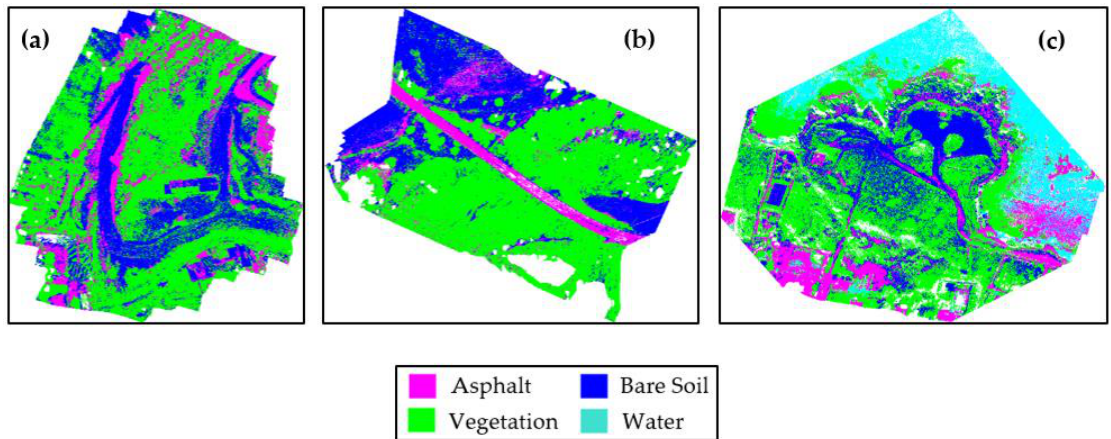
Figure 8. Most suitable results for the scenarios: ( a ), spatial resolution {2}, classification mode with vegetative index TGI; ( b ), spatial resolution {4}, classification mode with vegetative index IRG; ( c ), spatial resolution {3}, basic classification mode with RGB bands.